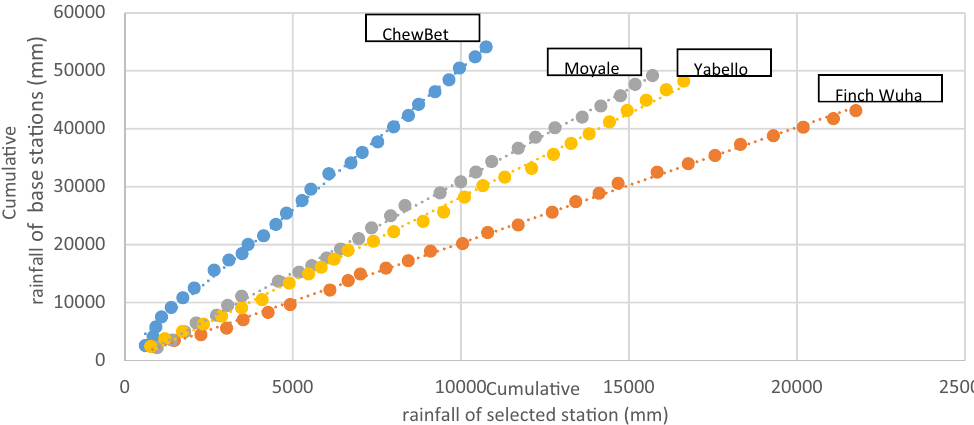
Figure 3. Double mass curves of the selected rainfall stations in the study